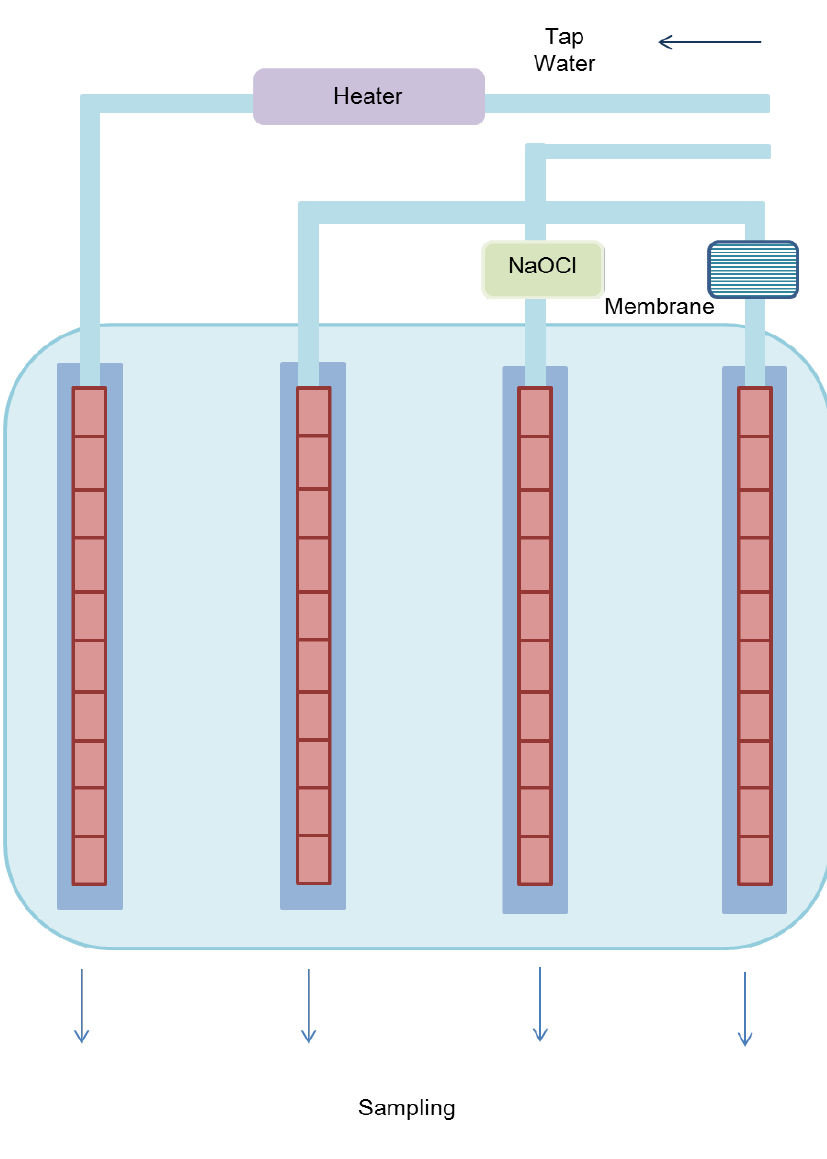
Figure 1. Schematic diagram of the experimental